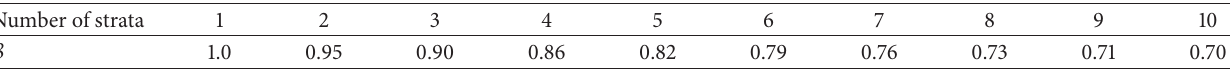
Figure 12: Histogram of the bolt load 𝑄 [kN/m]. Table 1: 𝛽 stratification